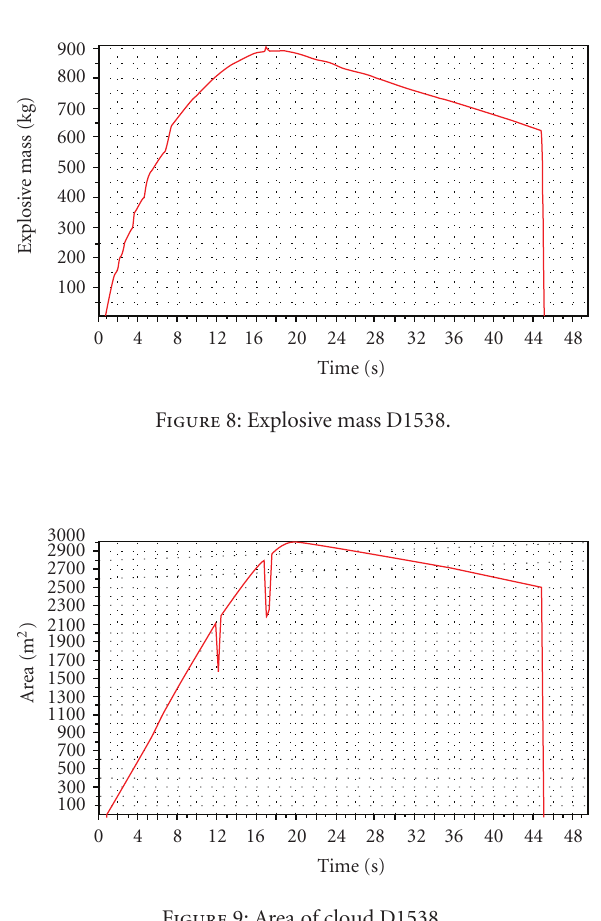
Figure 9: Area of cloud D1538.